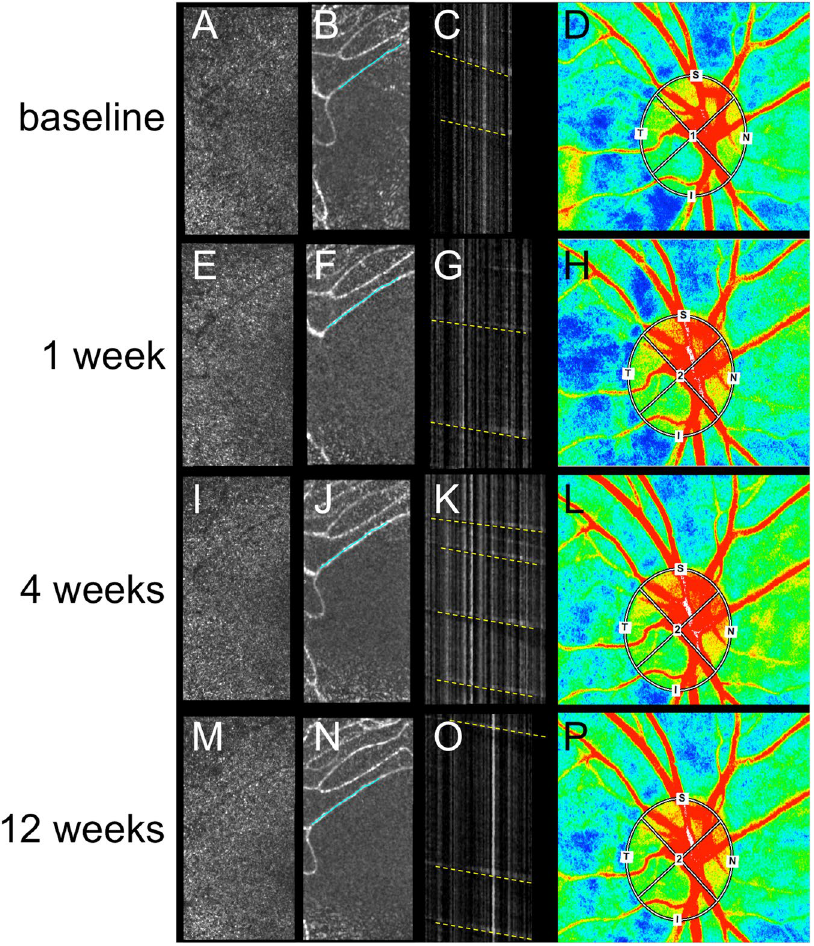
Figure 3. Representative case with primary open-angle glaucoma before and after tafluprost induction. ( A,E,I and M ) Adaptive optics scanning laser ophthalmoscopy (AOSLO) images. ( B,F,J and N ) Montage images from AOSLO videos. The identical vessels are depicted in all follow-up examinations (aqua lines). ( C,G,K and O ) Spatiotemporal images of the target vessel. Parafoveal blood flow velocity (pBFV), the reciprocals of the slopes of yellow dotted lines, increased in comparison to the baseline measurement (baseline, 1.11 mm/s; 1 week, 1.33 mm/s; 4 weeks, 1.36 mm/s; and 12 weeks, 1.23 mm/s). ( D,H,L and P ) Mean blur rate in the tissue area of the optic disc (MBR T ) measurements using laser speckle flowgraphy (LSFG; baseline, 14.9 AU; 1 week, 16.1 AU; 4 weeks, 15.4 AU; and 12 weeks, 15.1